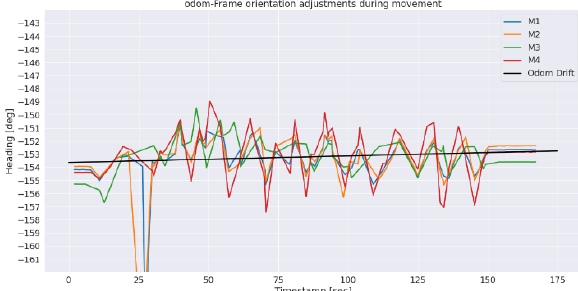
Figure 12. Adjustments on odom frame horizontal orientation over 10 laps Further investigation into systematic errors were performed. A comparison between the place of the marker detection in the camera frame and the resulting rotation of the odom frame shows, that depending on where the marker gets detected in the camera frame, the odom frame gets adjusted differently (Figure 13).